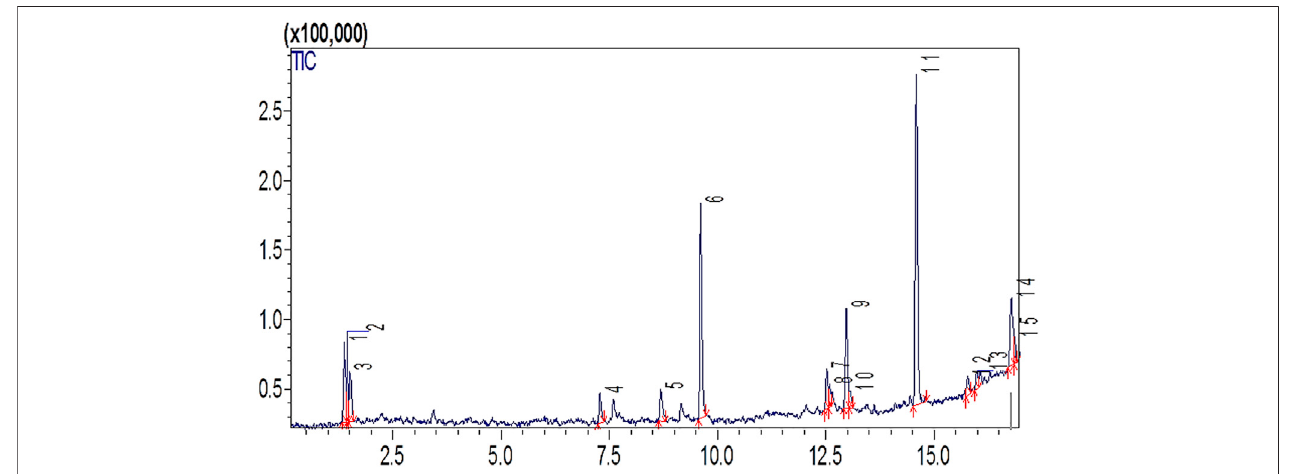
FIGURE 5 | GC-MS analysis of Cucumis melo var. agrestis biodiesel.